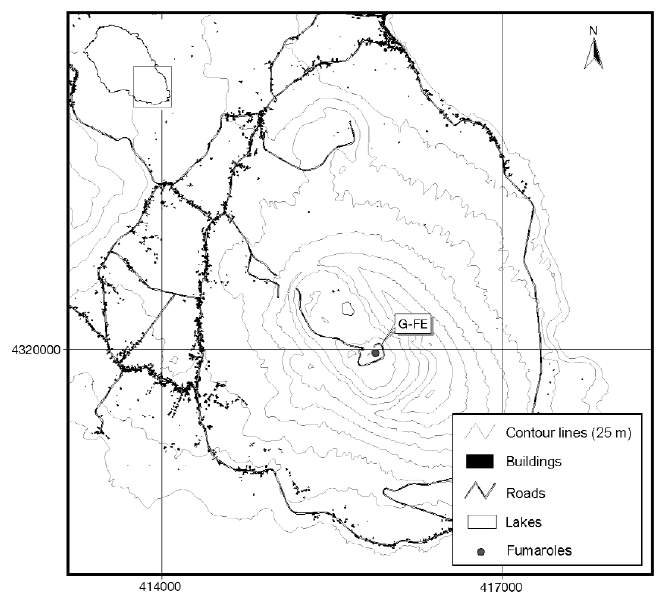
Fig. 5. Furnas do Enxofre fumarolic field at Graciosa Island (G-FE – Furnas do